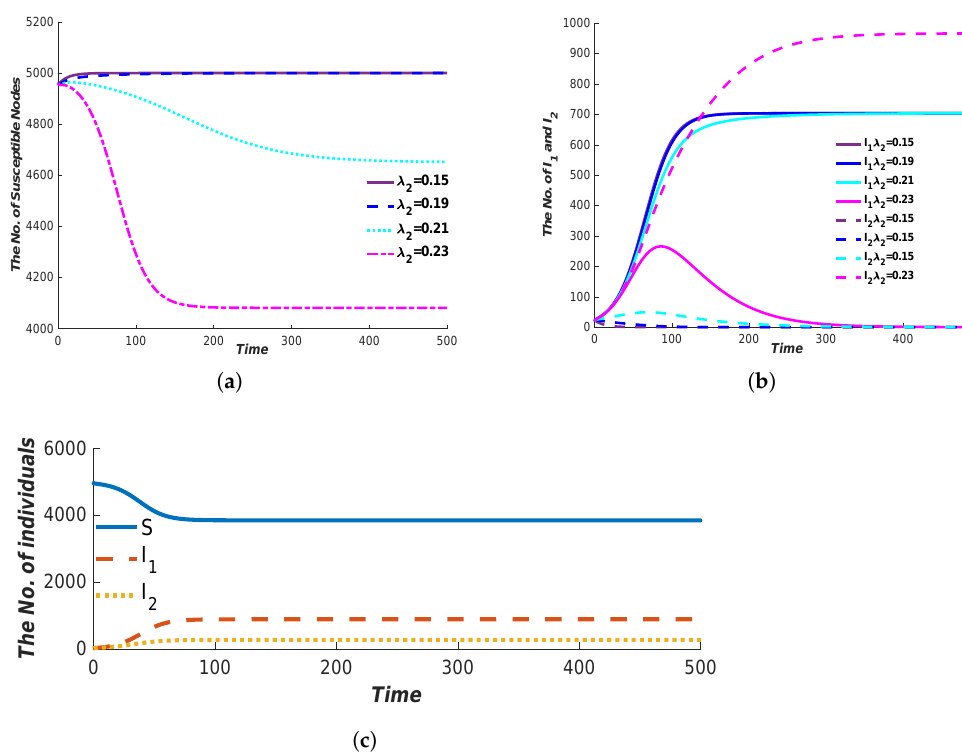
Figure 3. Two pathogens with cross-immunity. ( a )Evolutionof number of nodes in S state for various λ 2 : 0.15, 0.19, 0.21, and 0.23. Here, λ 1 = 0.25, γ 1 = 0.6, γ 2 = 0.4. ( b ) Evolution of number of nodes in I 1 , I 2 states for various λ 2 : 0.15, 0.19, 0.21, and 0.23. Here, λ 1 = 0.33, γ 1 = 0.6, γ 2 = 0.4. ( c ) Evolution of number of nodes in S, I 1 , I 2 states. Here, λ 1 = 0.36, γ 1 = 0.6, λ 1 = 0.24, γ 2 =